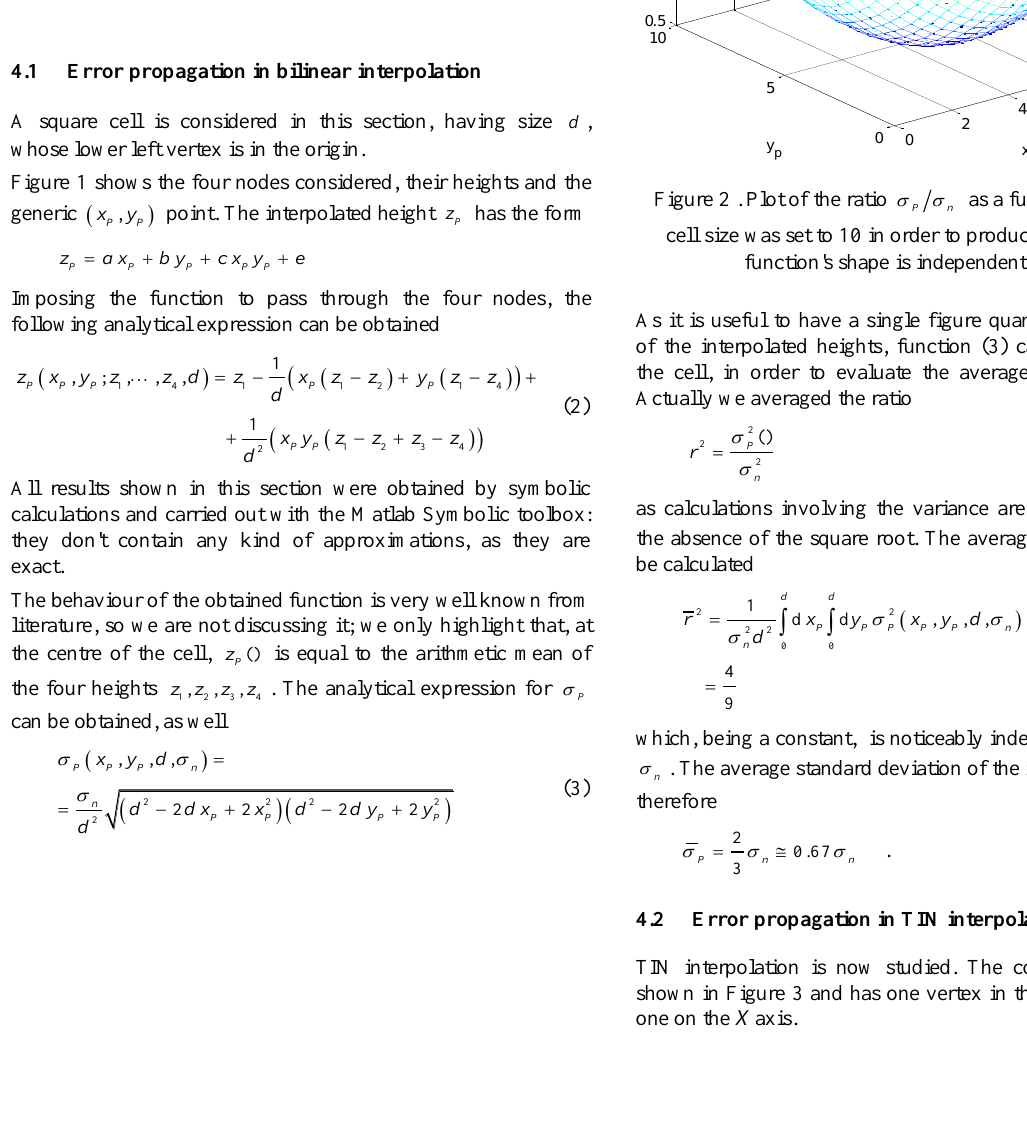
Figure 1. Bilinear interpolation.